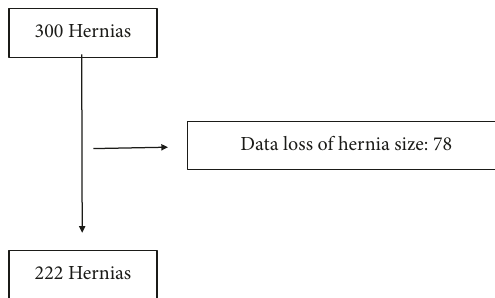
Figure 2: The number of eligible hernias following the exclusion criteria.